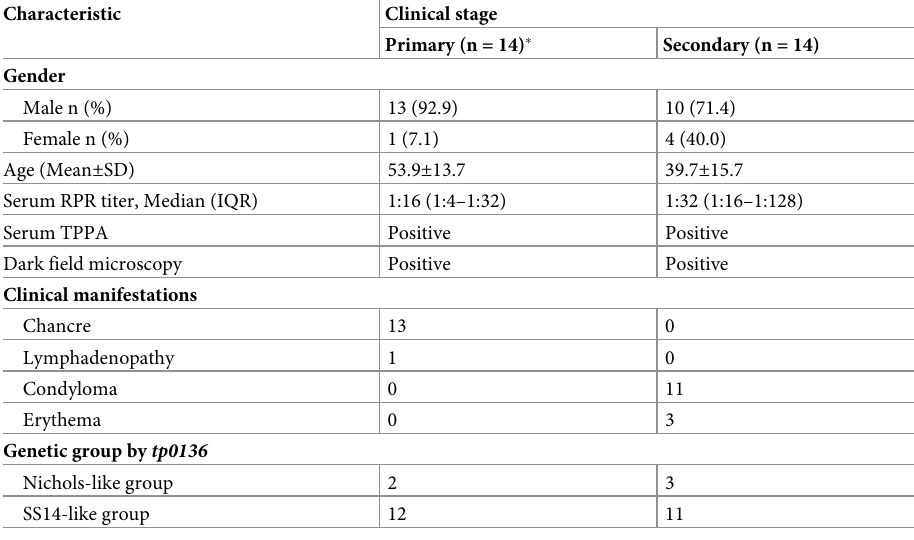
Table 1. Clinical characteristics of the study